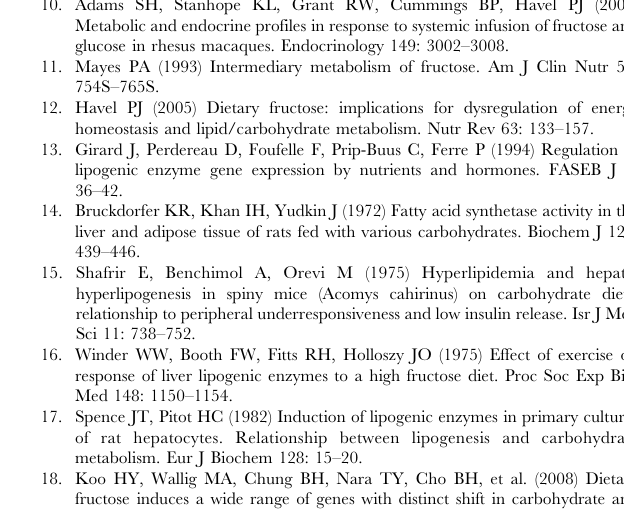
Figure S1 Decrease in fructose concentration in HepG2 fructose-enriched culture medium following 24 hr incu- bation periods. The change in fructose concentration in 5.5 mM MEM supplemented with 5 mM fructose after HepG2 incubation for 24, 48, and 72 hr. Media was replenished every 24 hr. Means 6 SEM are depicted; n= 6 or 12/group. (TIF) Figure S2 Elevated cellular concentrations of UDP- GlcNAc in HepG2 cells exposed to GlcN, but not glucose or fructose. Preliminary GC-TOF results quantifying UDP- GlcNAc levels in cells grown in 5.5 mM glucose, glucose + 5 mM fructose, or glucose + 10 mM GlcN for 1 hr following 48 hr incubation in treatment media. Unit of intensity is quantifier ion peak height. Means 6 SEM are depicted; n =2/group. (TIF) Figure S3 High levels of intracellular fructose and temporal changes in fructose-6-phosphate (F-6-P) in HepG2 cells grown in fructose-enriched medium com- pared with glucose and GlcN. Pilot study GC-TOF data showing ( A ) elevated cellular fructose levels and ( B ) relatively higher maintenance of F-6-P concentration in cells grown in 5.5 mM glucose + 5 mM fructose for 10 min to 24 hr following 48 hr incubation in treatment medium. Units of intensity are quantifier ion peak heights. Means 6 SEM are depicted; n= 2/ treatment per time point.